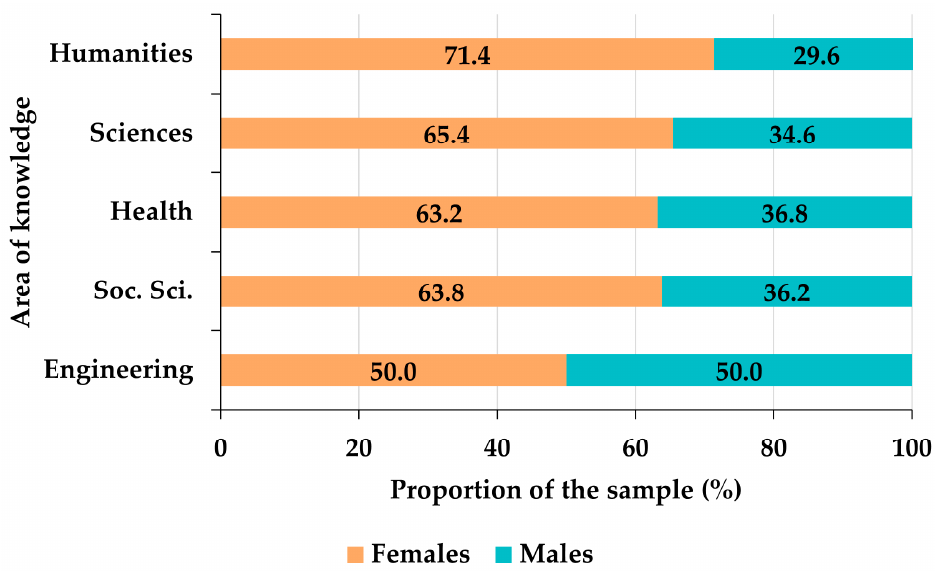
Figure 2. Distribution of the participants by knowledge area and gender.